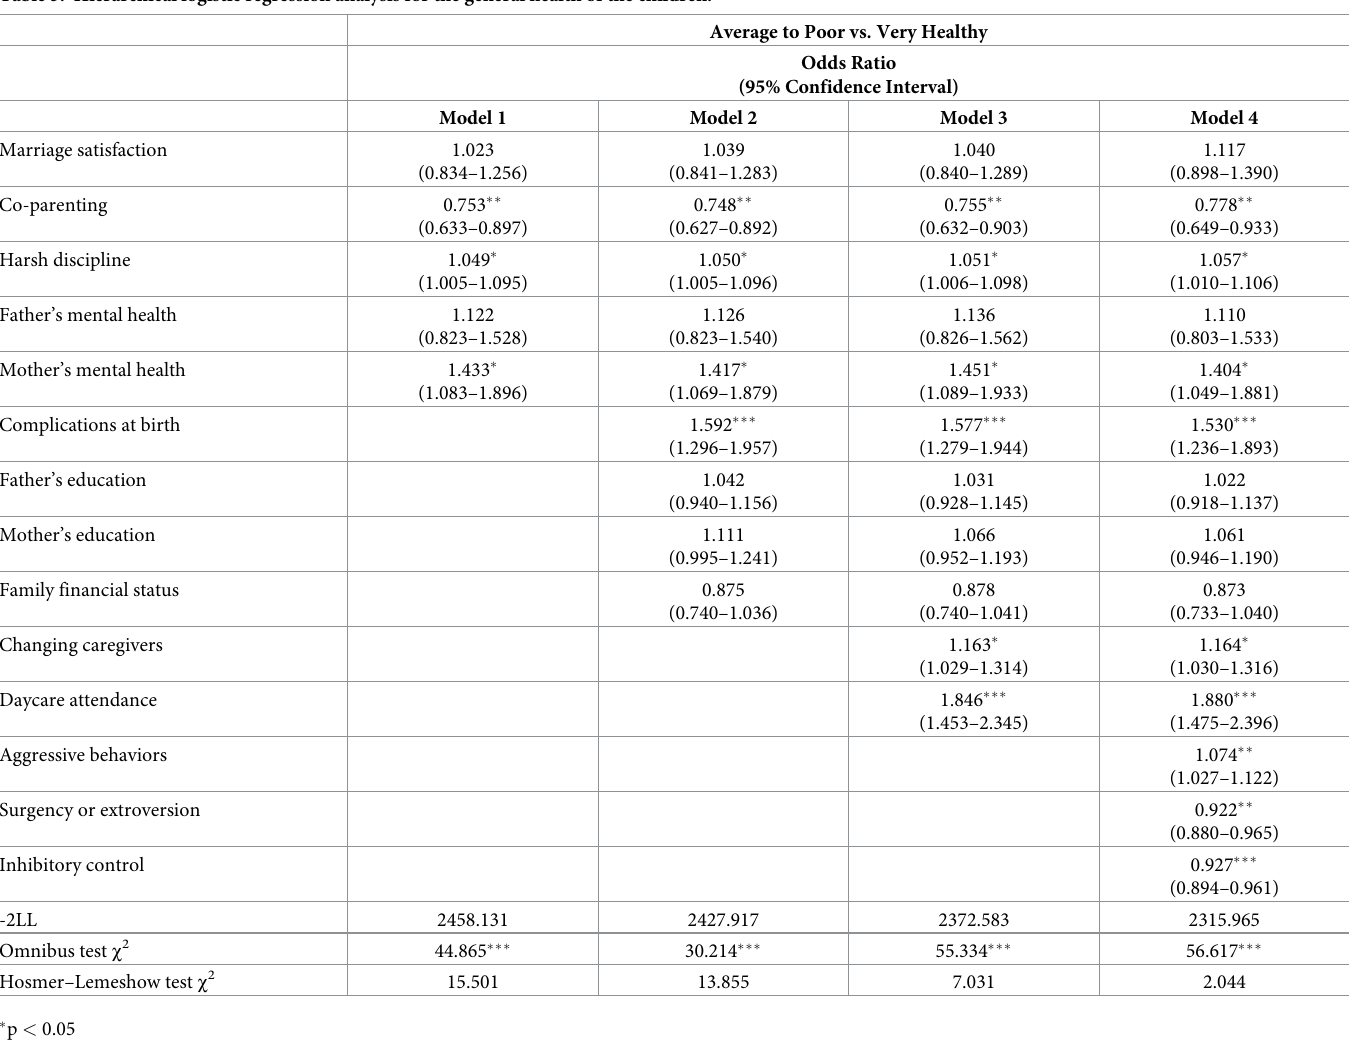
Table 3. Hierarchical logistic regression analysis for the general health of the